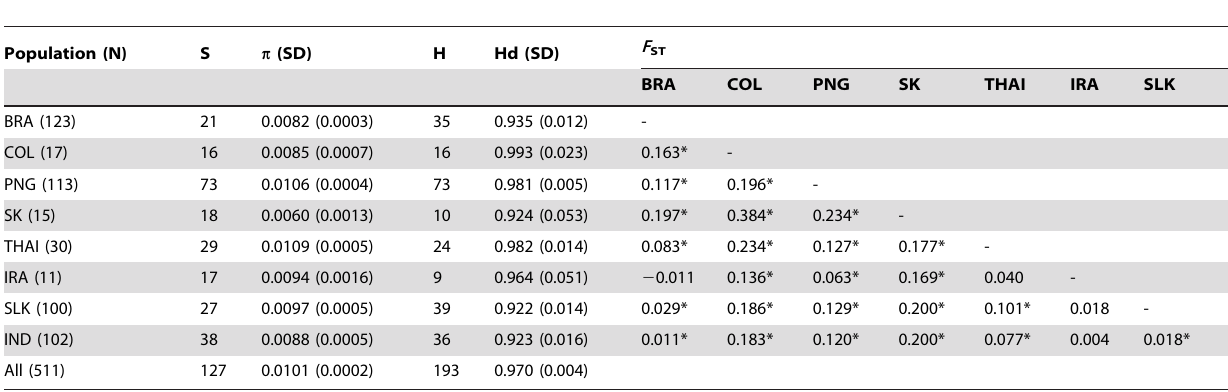
Table 1. Estimates of diversity and genetic differentiation for PvDBP II encoding gene among P. vivax isolates.